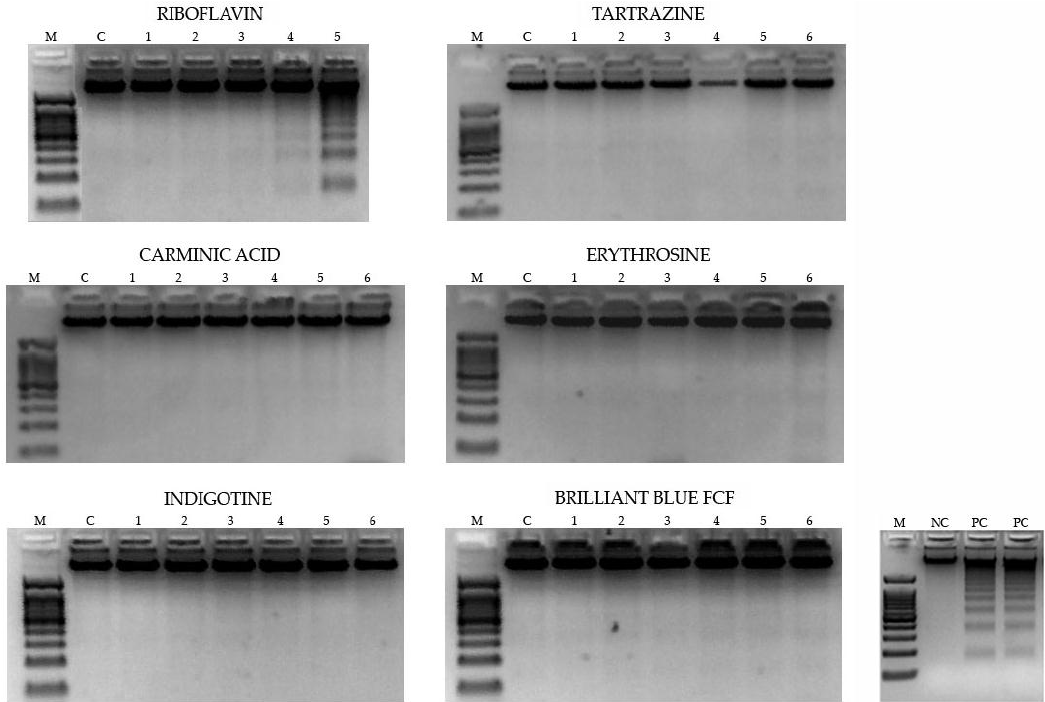
Figure 5. Internucleosomal DNA fragmentation in HL-60 cells. DNA-induced damage in promyelocytic HL-60 cells treated for 5 h with different concentrations of food colorings. M indicates the DNA size marker; NC indicates negative control treatment (RPMI); PC indicates positive control treatment (LBB). Numbers 1–6 indicate the different dilutions tested (see Table 1).